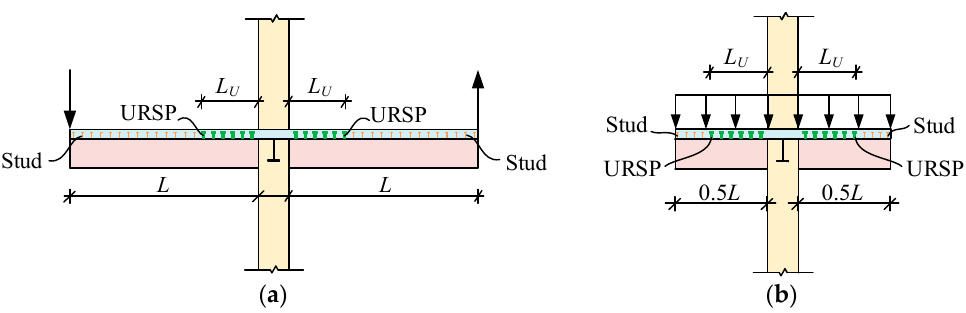
Figure 21. Two loading configurations of middle joints. ( a ) Load case 1; ( b ) Load case 2.